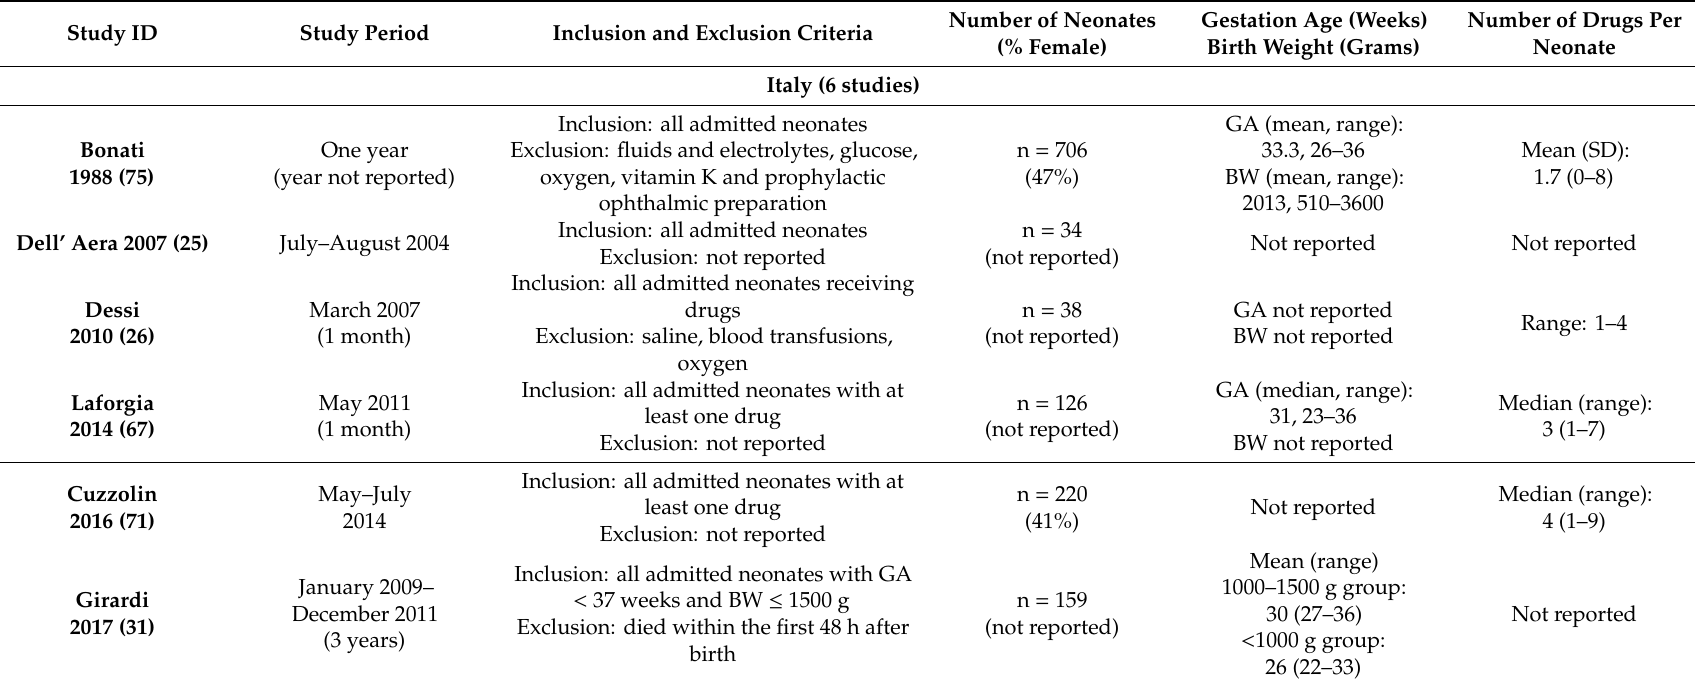
Table A2. Studies of drug utilization in Europe (27